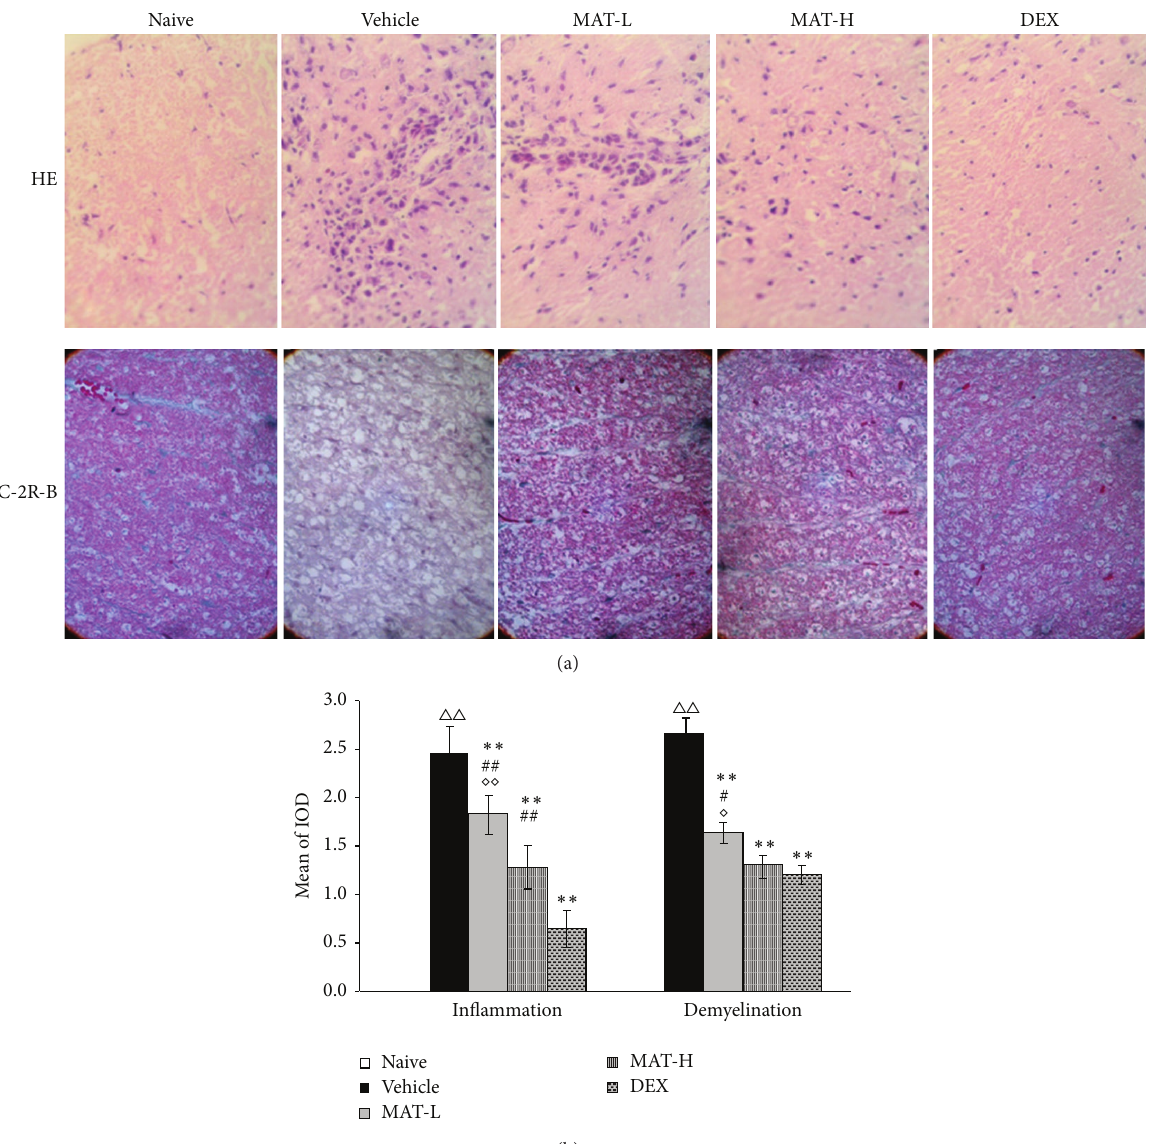
Figure 2: CNS infiltration and demyelination. At day 17 p.i., spinal cord lumbar enlargements were harvested and transverse sections were stained with H&E and C-2R-B. (a) Digital images were collected under bright-field setting using a × 40 objective. (b) Quantitative analysis. Mean values and SD are shown ( 𝑛 = 8 each group). △△ 𝑃 < 0.01 , compared to naive group; ∗∗ 𝑃 < 0.01 , compared to vehicle-treated group; # 𝑃 < 0.05 and ## 𝑃 < 0.01 , compared to DEX group; ◊ 𝑃 < 0.05 and ◊◊ 𝑃 < 0.01 , comparison between MAT-L and MAT-H